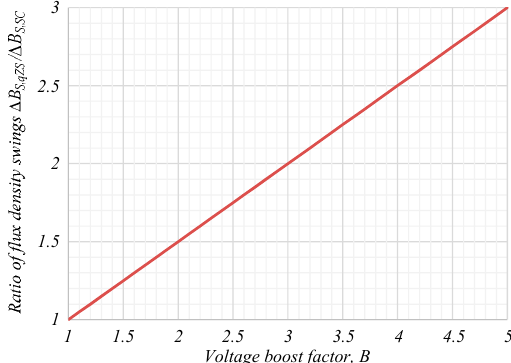
Figure 15. Ratio of the flux density swings at different input voltage boost factors.